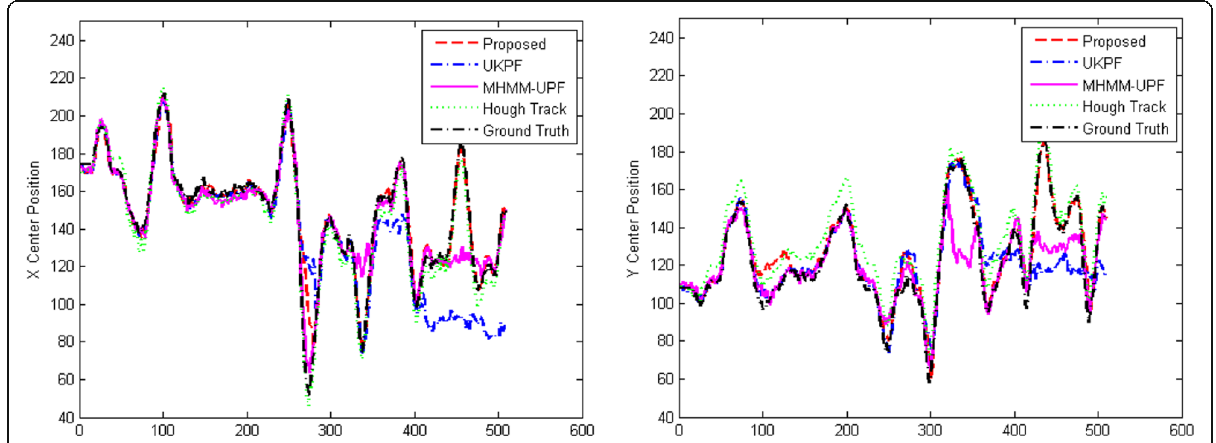
Fig. 11 Tracking result of target center of gravity of “ Hand1. ” Left — horizontal center of gravity; right — vertical center of gravity